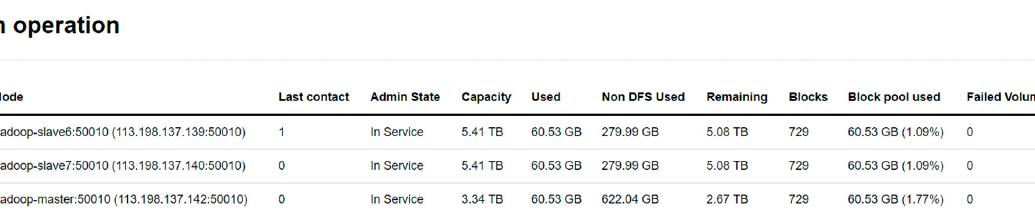
Figure 10. Kafka Producers with partitions and threads (gathering the sensing data from programmable logic controller (PLCs)).